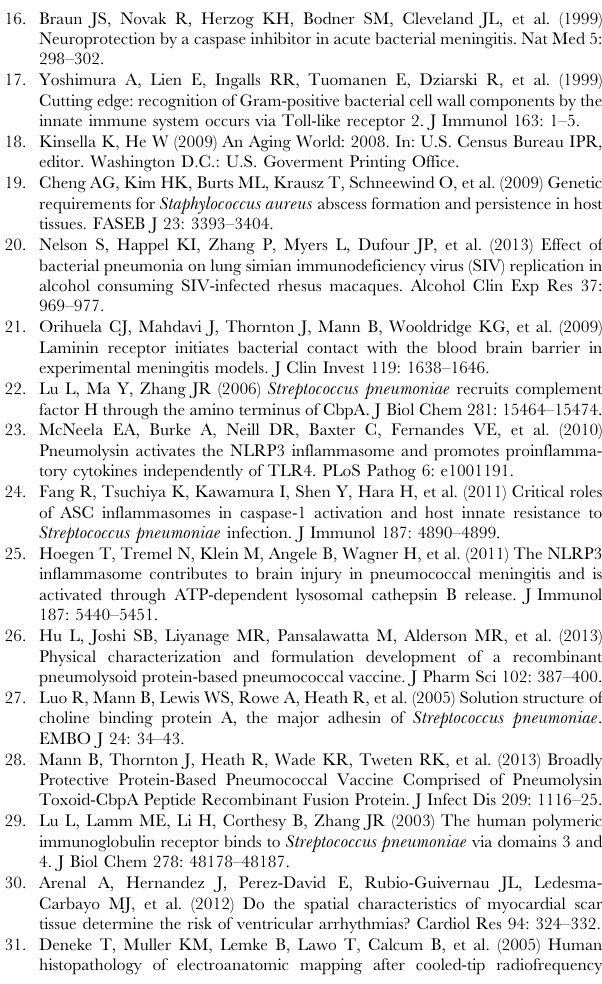
Figure S1 ECG tracings from individual mice (M) following intraperitoneal challenge with S. pneumoniae . Note the onset of aberrant electrophysiology. Saline challenged controls (C) showed no disturbances through 48 h despite identical anesthesia treatment and repeated ECG measurements. Figure S2 Microlesion lacking immune cell infiltrates and filled with Streptococcus pneumoniae found in the gastrocnemius muscle of a mouse 30 h after intraperitoneal challenge. Figure S3 Cell cytotoxicity following pneumococcal adhesion and invasion. Cytotoxicity as measured by release of lactose dehydrogenase in cell culture supernatants following a 30 min incubation for pneumococcal adhesion or a 2 h incubation for